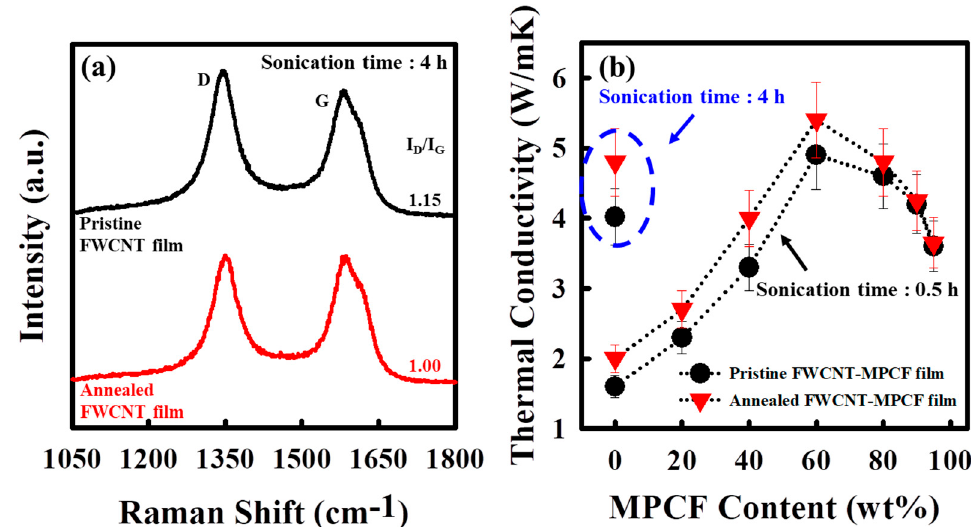
Figure 4. ( a ) Raman spectra of the pristine and annealed (at 1000 °C ) FWCNT films (ultrasonication for 4 h) (The D -band (approximately 1350 cm − 1 ) and G-band (approximately 1580 cm − 1 ) are related to defect-induced structural disorders and sp 2 carbons, respectively.); ( b ) thermal conductivity of FWCNT-MPCF hybrid films with different MPCF content (length: 200 μ m; ultrasonication for 0.5 or 4 h) before and after thermal annealing (at 1000 °C ).